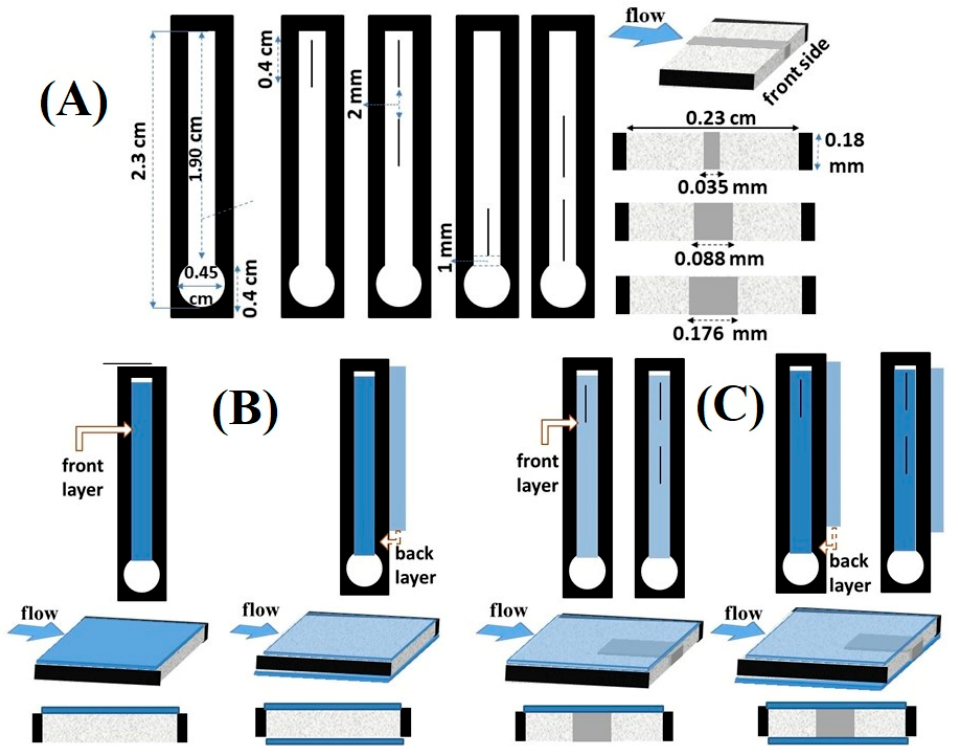
Figure 1. Paper channels with wax-printed fluid delays and accelerators. ( A ) Top view diagrams (left side) and cross-section (right side) displaying regular channels as well as wax-printed linear line delays at the end and the beginning of the fluid flow path. The printed width of the linear delays (before heating) varied from 0.035 to 0.175 mm. ( B ) Top view diagrams (upper) and cross-section (bottom) displaying wax-printed layers placed on top or top–bottom of the regular channels. ( C ) Top view diagrams of (upper) and cross-section (bottom) displaying wax-printed layers placed on top or top–bottom of the channels containing linear wax-printed linear line delays at the end of the fluid flow path. The printed width of the linear delays (before heating) varied from 0.035 to 0.175 mm.